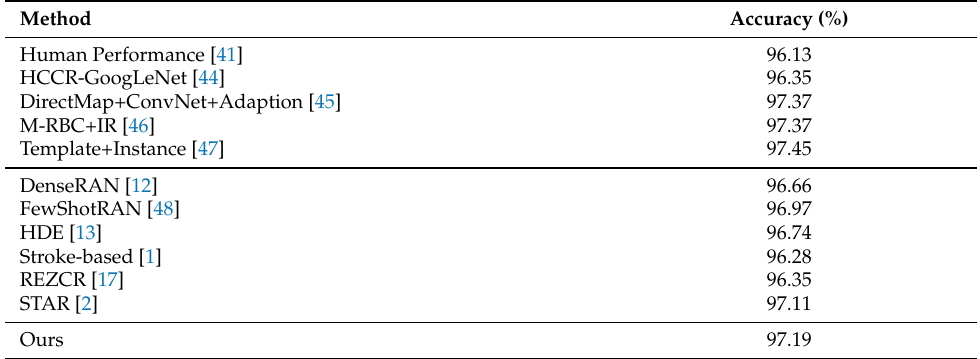
Table 2. The results of seen Chinese character recognition with various approaches.